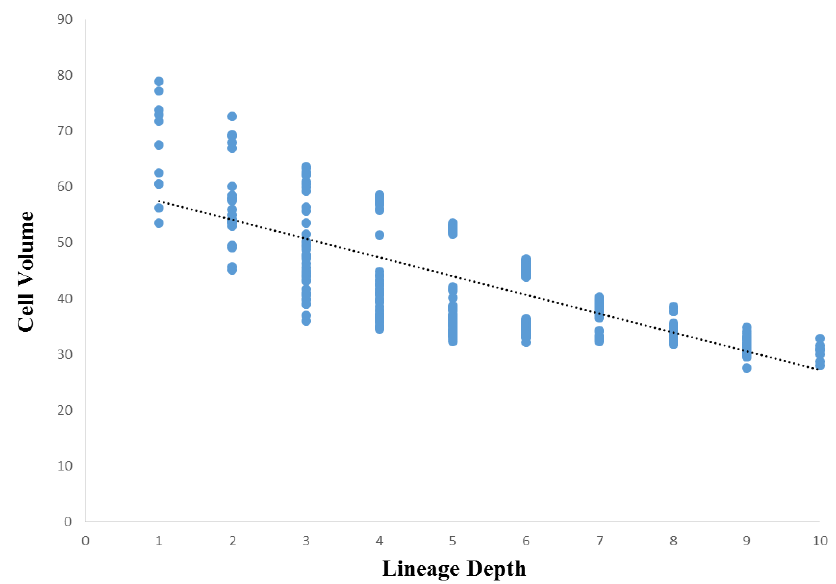
from the one-cell stage (depth of 0).